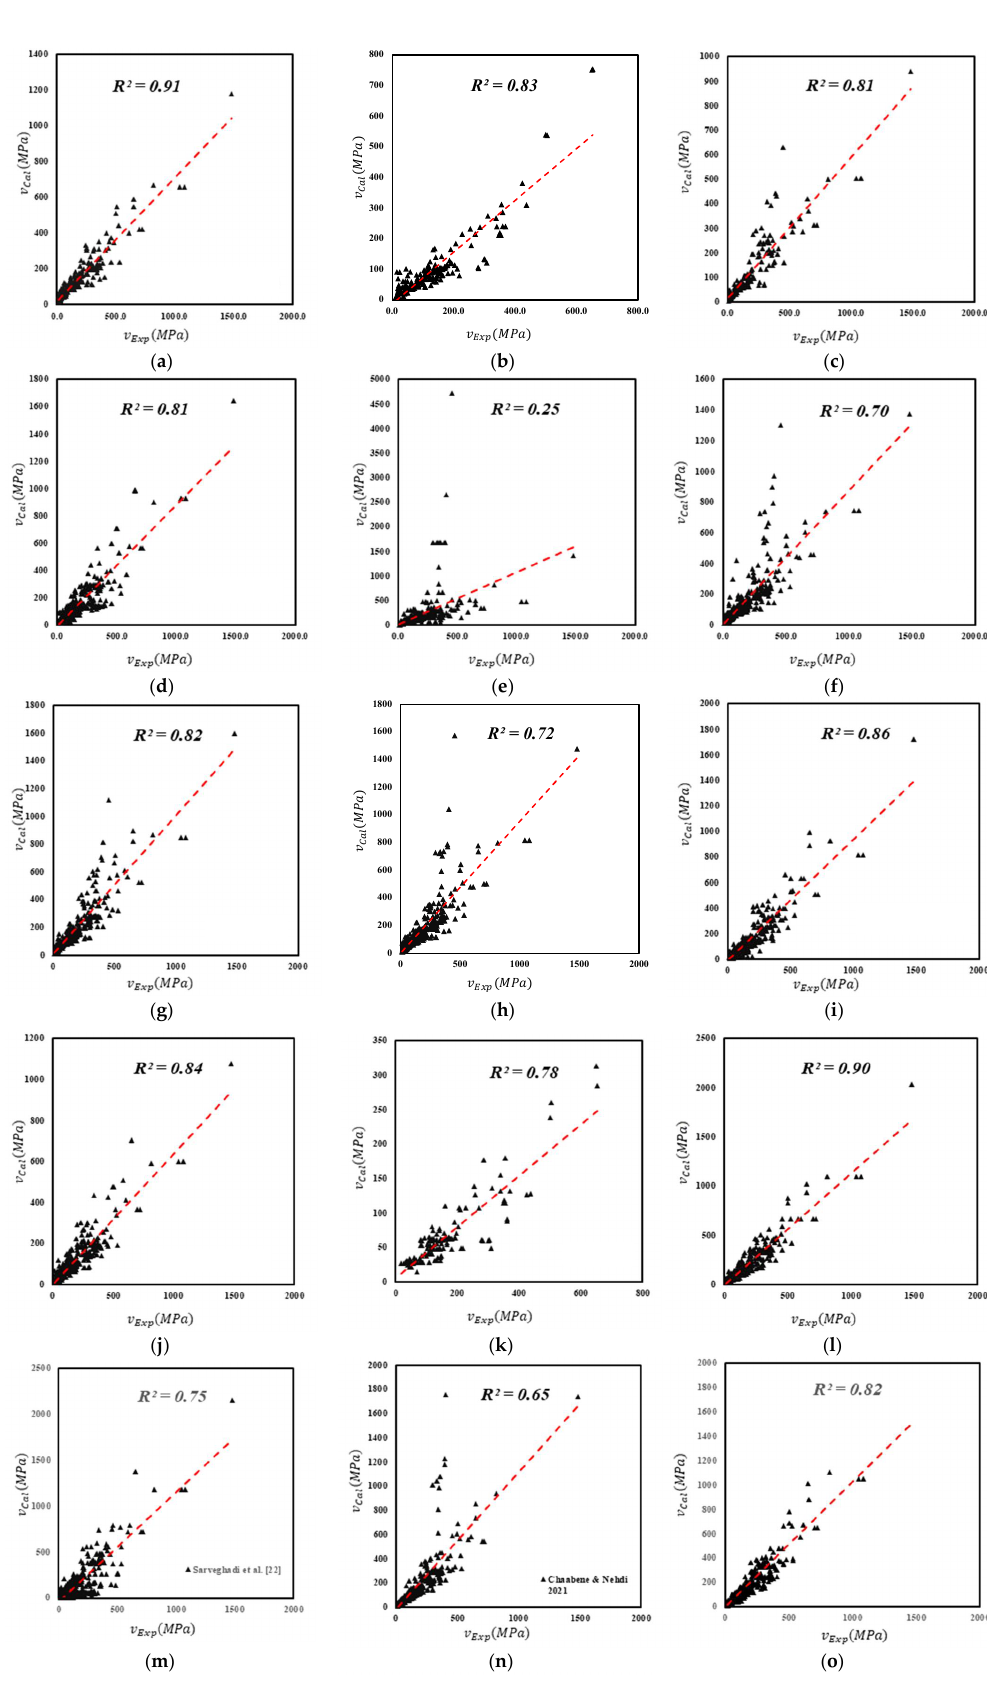
( p ) Figure 7. Comparison of proposed model with existing models: ( a ) Greenough and Nehdi [17], ( b ) Kunita et al. [27], ( c ) Shin et al. [46], ( d ) Sharma et al.[12], ( e ) Imam et al.[47], ( f ) Ashour et al.[48], ( g ) Kwak et al.[13], ( h ) Narayanan and Darwish [49], ( i ) Shahnewaz and Alam [18], ( j ) Shahnewaz amd Alam[51], ( k ) RILEM[52], ( l ) Gandomi et al [50]., ( m ) Sarveghadi et al [16]., ( n ) Chaabene and Nehdi 2021 [53], ( o ) Sabetifar et al.[22], ( p ) Proposed model.